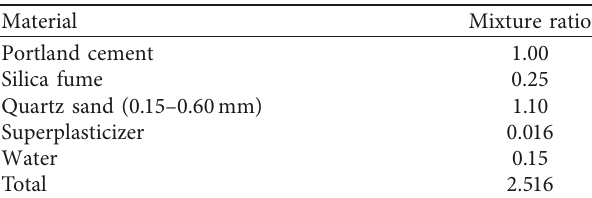
Table 11: Concrete mixture ratios according to Richard and Cheyrezy [37].